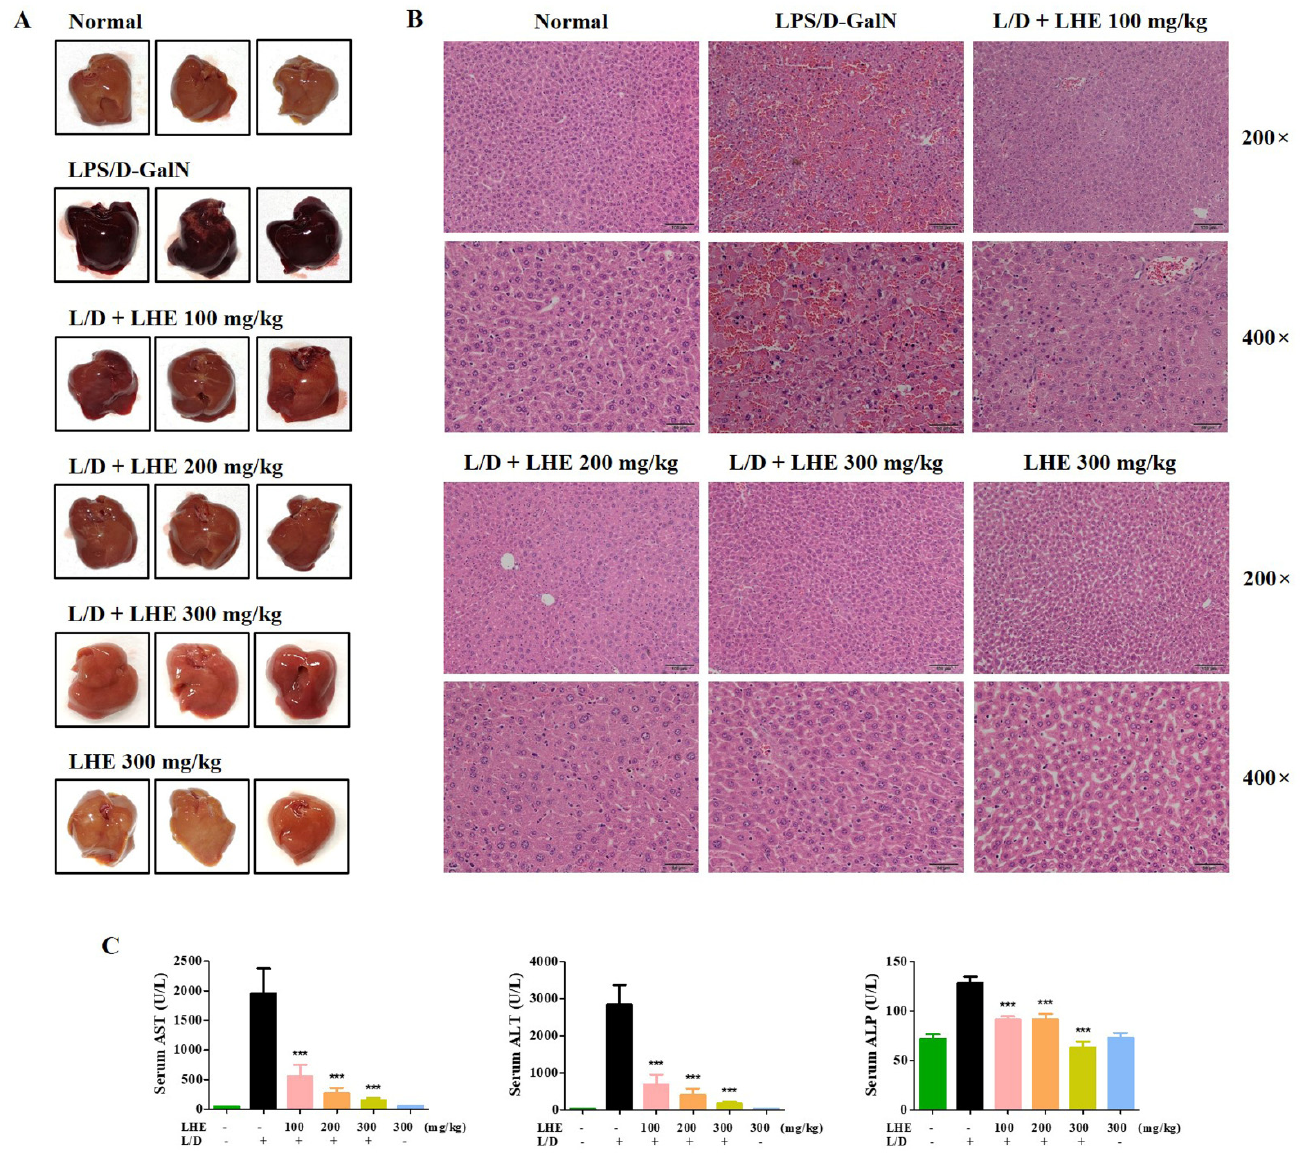
Figure 5. Effects of LHE on ( A ) mouse liver injury, ( B ) histopathological changes of mouse liver, and ( C ) serum aminotransferase levels in LPS/D-GalN-induced hepatitis mouse model. Mice were pretreated with LHE or vehicle once per day for 6 days. Then, LPS/D-GalN was injected 1 h after the last administration. After 6 h, mice were sacrificed, and liver tissue and blood samples were collected. Mouse serum was prepared via centrifugation. ( A ) Images of hepatitis lesions in mice. ( B ) H&E staining of mice liver. Scale bars = 100 μ m (200×) or 50 μ m (400×). ( C ) Serum aminotransferase levels were analyzed using an automated clinical chemistry analyzer. Data were expressed as means ± SEM ( n = 9). *** p values of < 0.001 (vs. LPS/D-GalN) were considered statistically significant.